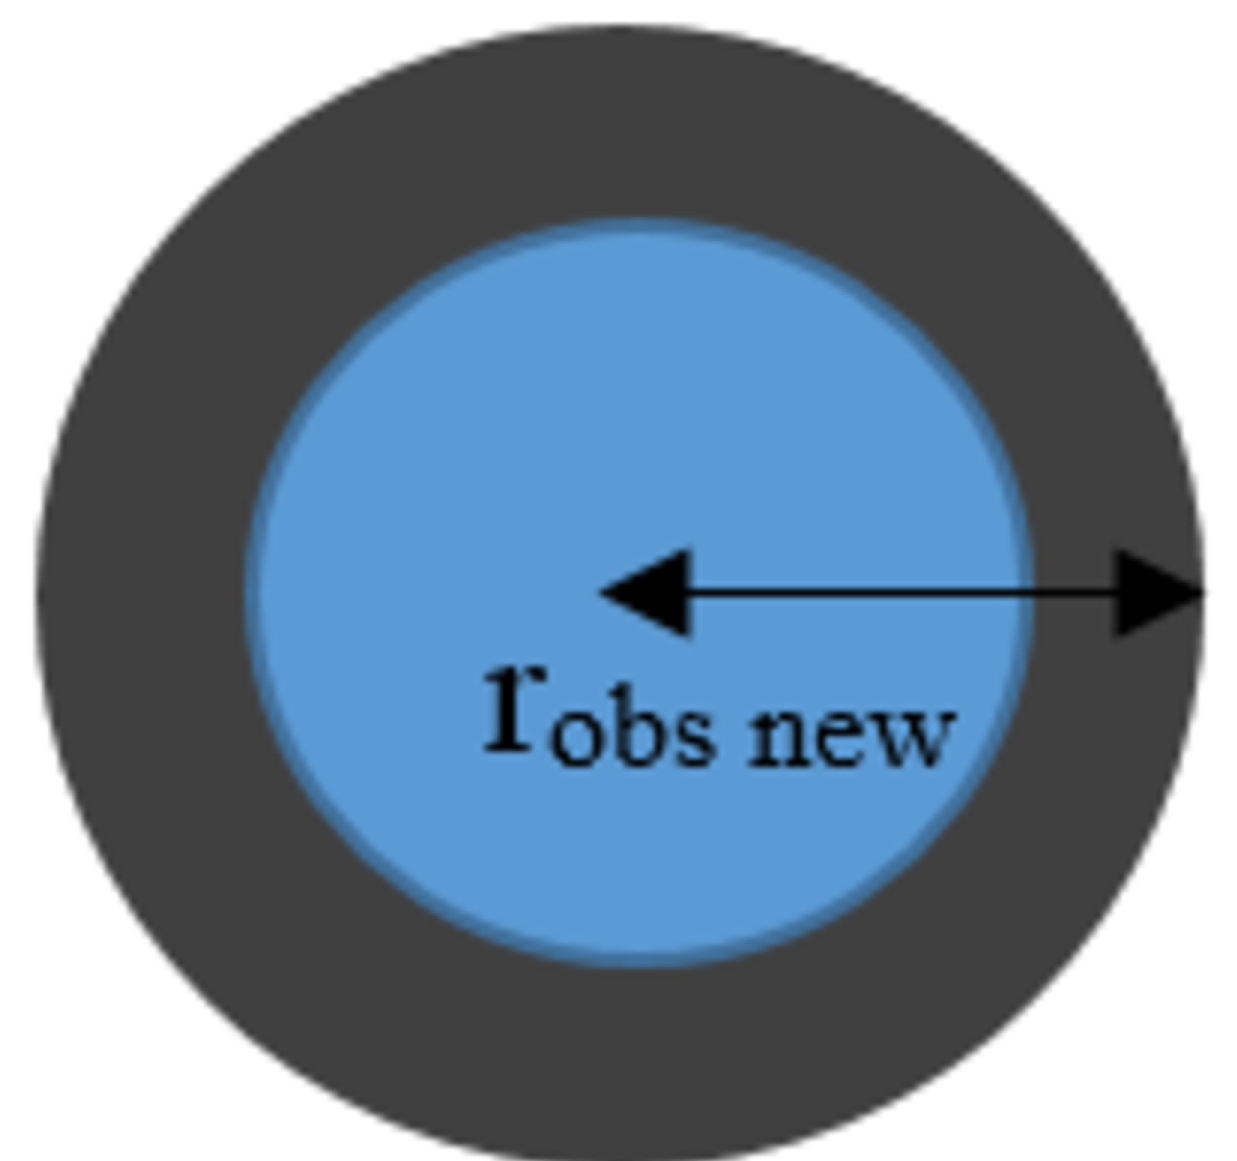
Fig 3. The obstacles when the size of the radius is